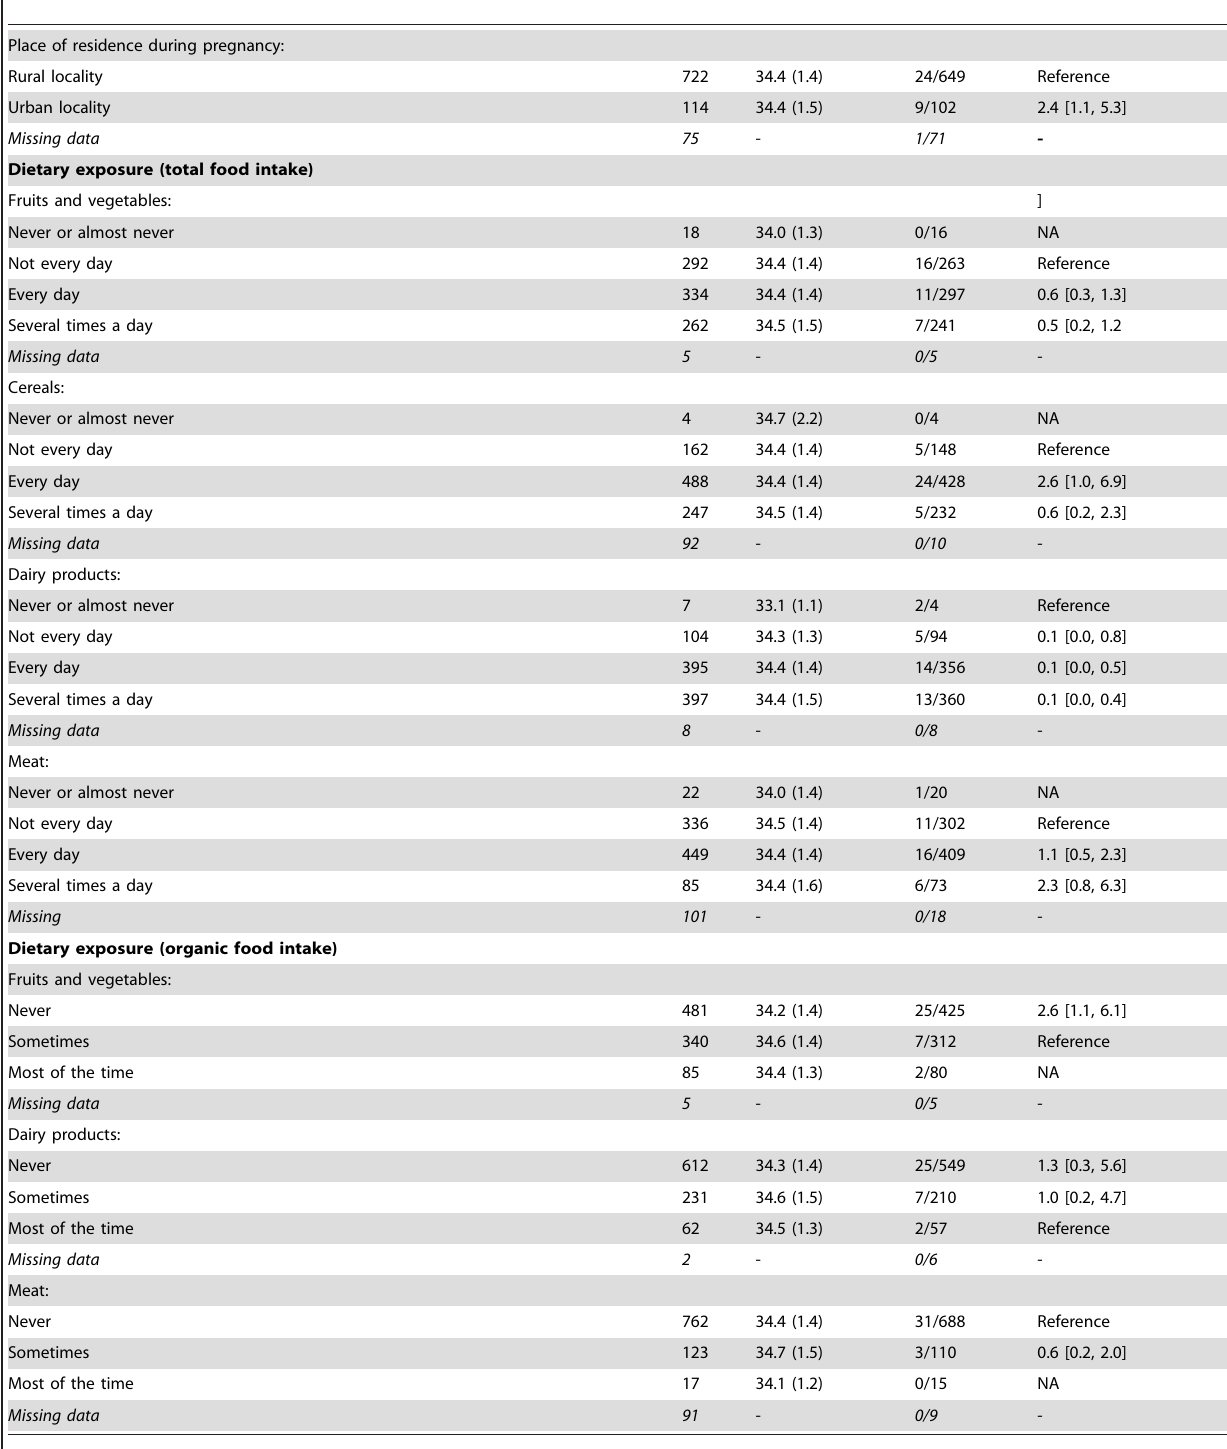
Table 12. Multivariate associations between (i) variables related to in utero exposure to pesticides, (ii) head circumference at birth (HCB, in cm) and (iii) small head circumference at birth